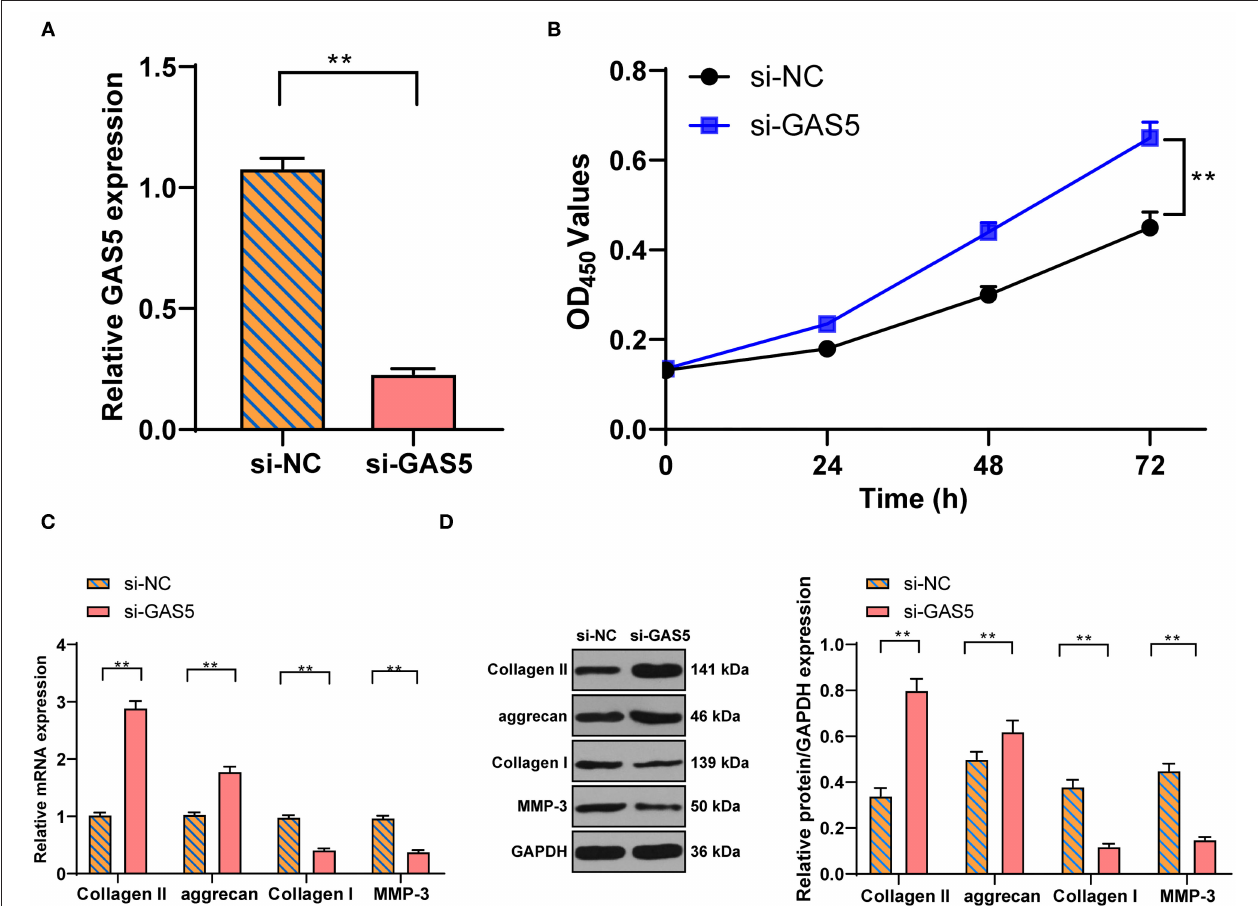
FIGURE 2 | Inhibition of GAS5 enhances the viability of degenerative NPCs and promotes ECM synthesis. Si-GAS5 was transfected into degenerative NPCs, the transfected si-NC was used as the control, and then the expression of GAS5 in degenerative NPCs was detected by (A) RT-PCR to verify the transfection efficiency; then (B) CCK-8 test was used to detect the survival rate of degenerative NPCs; (C,D) RT-PCR and Western blot were used to detect the expression of ECM-related genes in NP. The cell experiment was repeated three times, and the data were expressed as mean ± standard deviation and analyzed using the independent t -test; ** p <